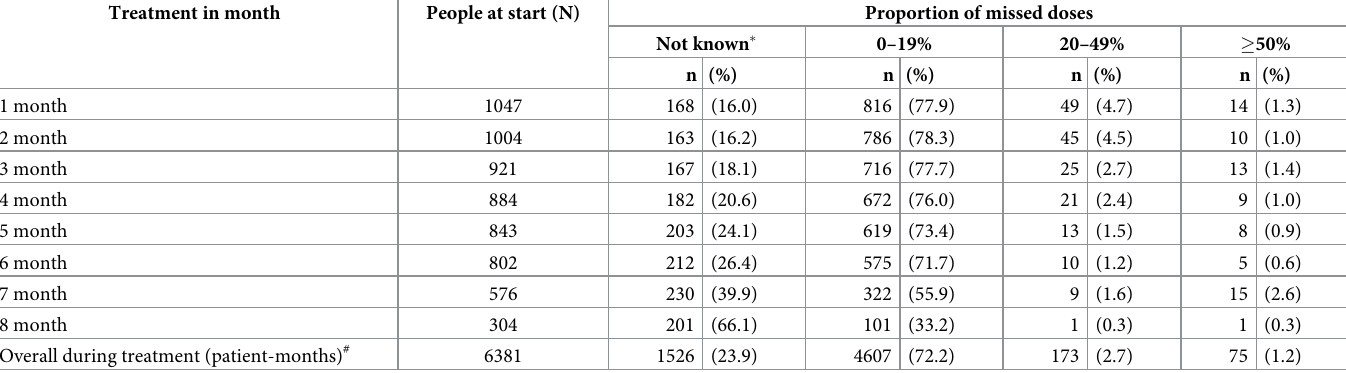
Table 3. Treatment adherence measured as monthly proportion of missed doses among notified people with TB using EMM within first month of diagnosis in the 30 selected counties of China between July and December, 2018 [N = 1047]. Treatment in